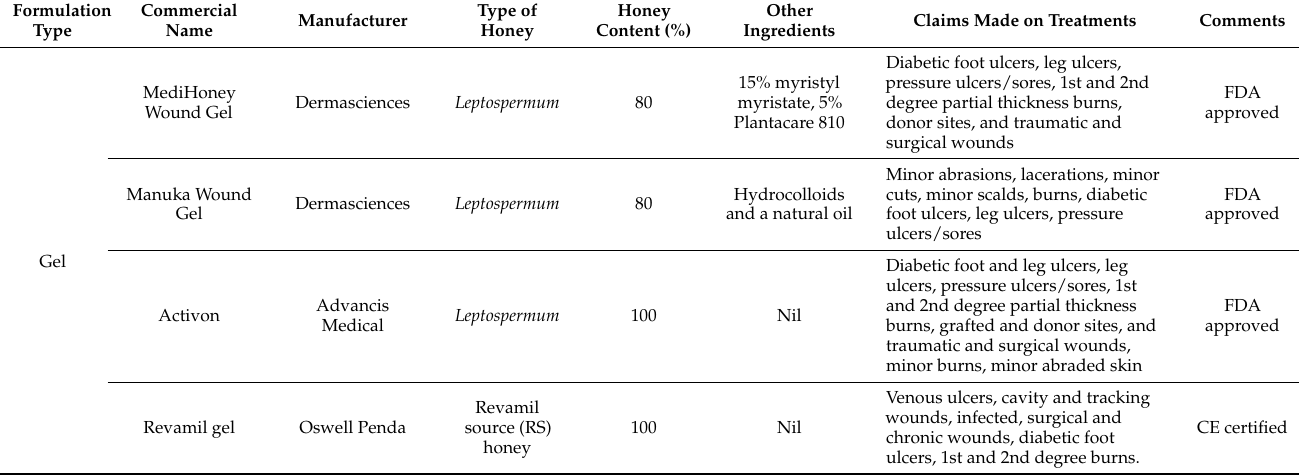
Table 1. Commercial honey-based